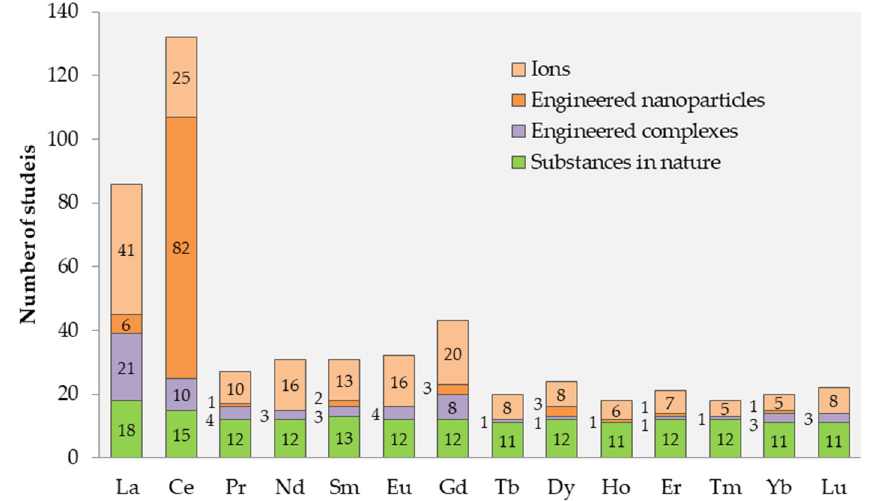
Figure 2. The number of papers for individual Ln compounds in the chemical form of: ions, nanoparticles, complexes or as present in the natural environment (monitoring data). The number of papers is indicated inside or left to the respective column. The pool of initial data analysed in this Figure is described in Table 1 (reviews have been omitted).